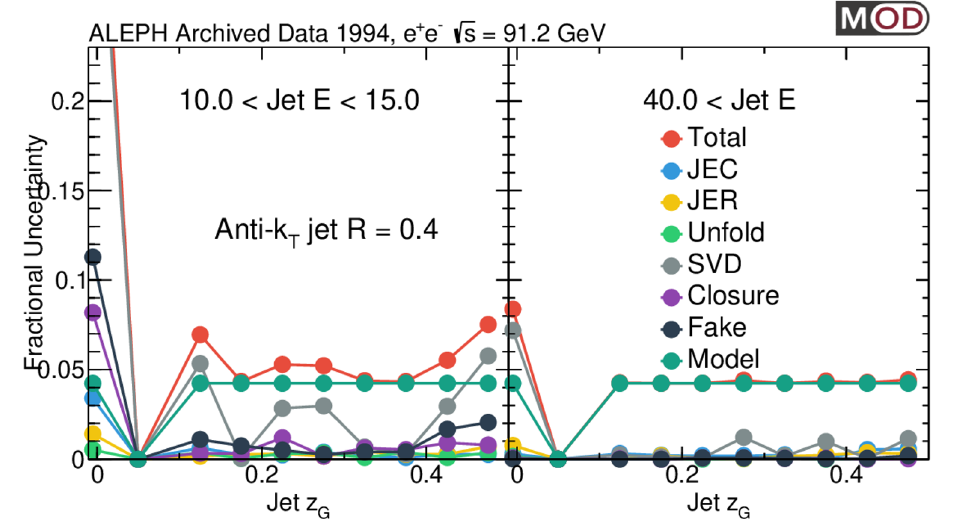
Figure 8 . Summary of the size of relative systematic uncertainty from different sources for z G , in bins of jet E from 10–15 GeV (left panel) to above 40 GeV (right panel).